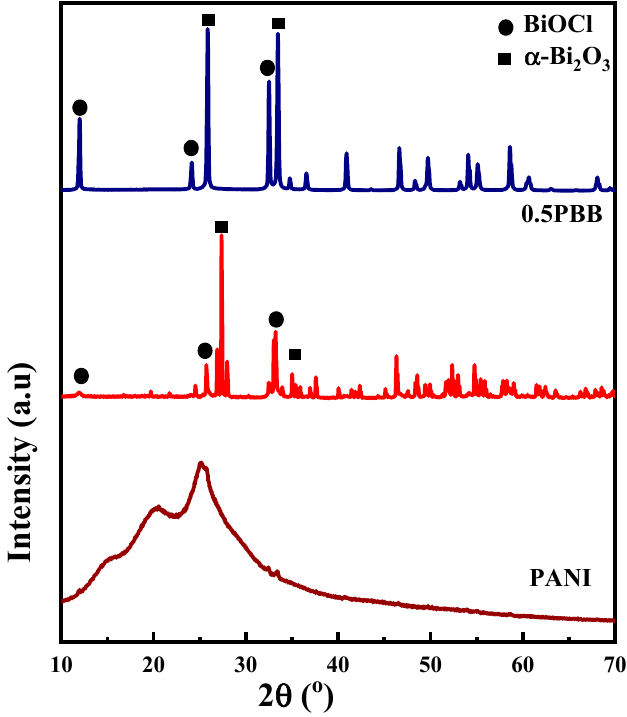
Figure 1. XRD patterns of PANI, Bi 2 O 3 -BiOCl, and 0.5PBB. The efficacious insertion of Bi 2 O 3 -BiOCl into the PANI matrix was also determined via FTIR. Figure 2 shows the acquired spectra of Bi 2 O 3 -BiOCl, PANI, and 0.5PBB. Typical bands at 1571 cm − 1 and 1465 cm − 1 ascribed to C=N and C=C stretching vibrational modes of quinoid and benzenoid rings were recorded in the PANI’s spectrum [48,49]. Likewise, the 1271 cm − 1 band is ascribed to the C-N benzenoid stretching, while the 805 cm − 1 is assigned to the out-of-plane deformation of C-H in the benzene ring [50]. The presence of the benzenoid and quinoid rings implies that PANI was obtained in its emeraldine form (half-oxidized) [51]. The FTIR spectrum of Bi 2 O 3 -BiOCl showed typical bands at 847 cm − 1 and 494 cm − 1 , ascribed to Bi-O-Bi and Bi-O stretching, respectively. The band at 847 cm − 1 is characteristic of Bi 2 O 3 and related to the Bi-O-Bi vibration mode (Figure S2). Moreover, the bands at 1035 and 1103 cm − 1 can be ascribed to the symmetric and asymmetric stretching vibrations of Bi-Cl. The band at 1382 cm − 1 is assigned to the NO 3 − group [52]. The presence of NO 3 − indicates a potential competition of NO 3 − with Cl − in emeraldine salt structure [53]. After HCl treatment, the main band of Bi 2 O 3 decreased, confirming the growth of BiOCl on Bi 2 O 3 to construct the heterostructure, according to the literature [54]. The FTIR spectrum of the 0.5PBB nanocomposite exhibits the characteristic bands of both the components, organic and inorganic. The high intensity of the signals related to the polymeric components partially covers those of Bi 2 O 3 -BiOCl, although the typical band at 1143 cm − 1 related to the Bi-Cl stretching vibration is well evident [55]. Eventually, the slight shift of the bands of the PANI/Bi-based materials confirms the fruitful interaction between the two components of the nanocomposite, in agreement with the XRD results.